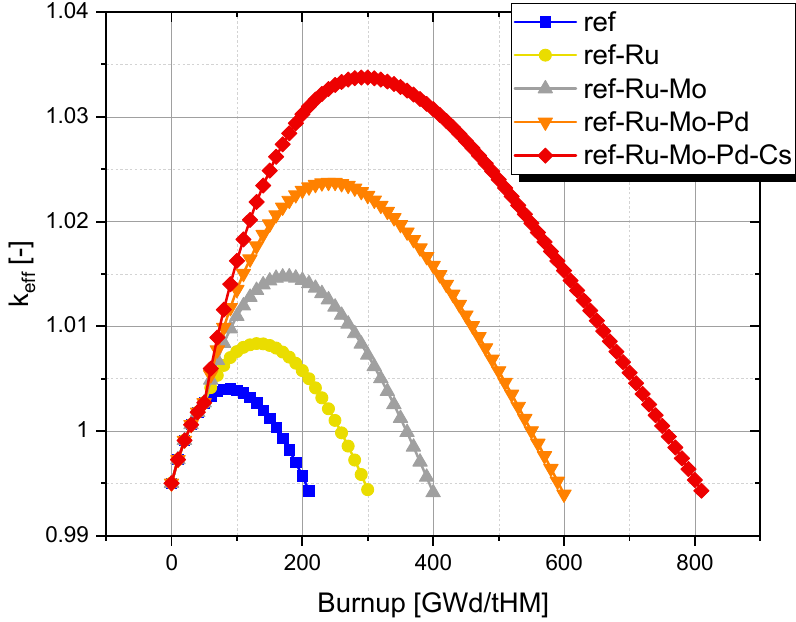
Figure 9. Development of the system criticality over burnup, considering the stepwise separation of different elements at 50 GWd/tHM with a 20% rate of salt being cleaned every step, based on a simulation using 10 GWd/tHM steps.